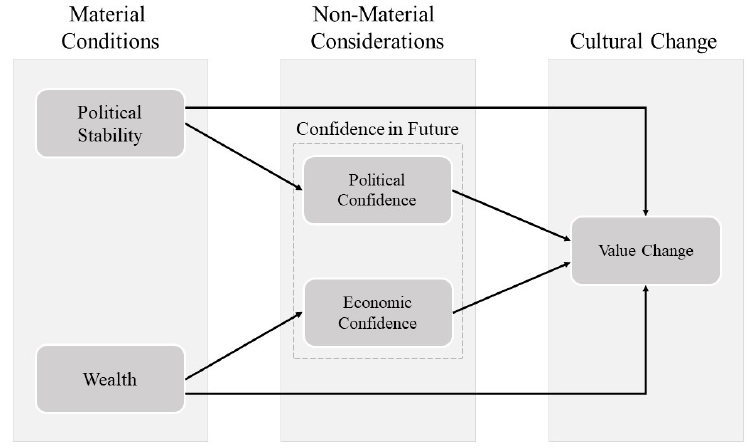
Figure 1. The theoretical framework that explains the relationships between material conditions, non-material considerations, and cultural change.